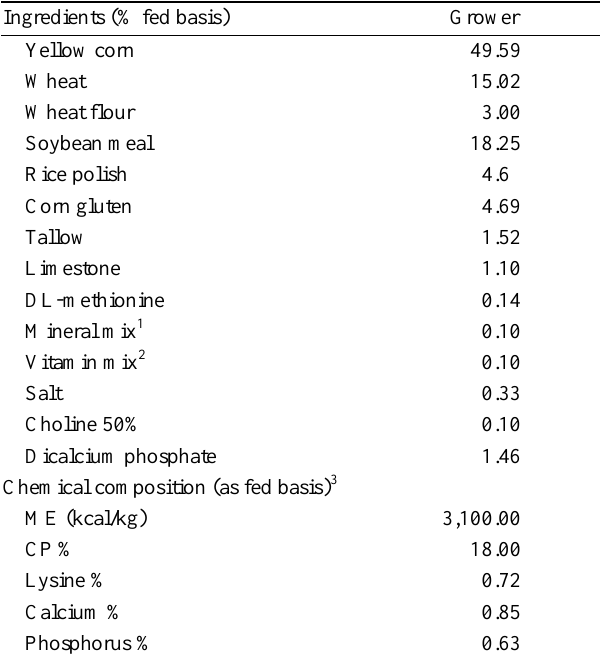
Table 2. Ingredients and chemical composition of basal